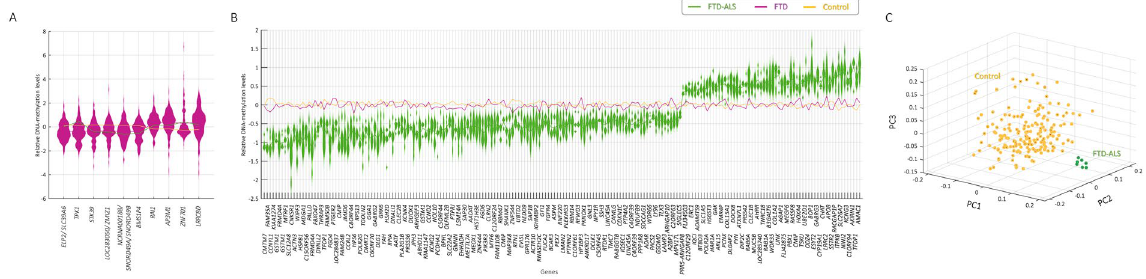
Figure 1. Differential methylated genes for FTD and FTD-ALS. Violin plot depicting the significant differential cytosine DNA-methylated genes are depicted for ( A ) all the 128 FTD cases, and ( B ) the FTD-ALS cases by comparison to control cases. Genes are sorted based on T-statistics. Genes with relative value lower than 0 are DNA hypomethylated and relative value higher than 0 are DNA hypermethylated. The green, purple and yellow lines depict the average value for respectively FTD-ALS, FTD and control cases. ( C ) Principal Component analysis on the differential DNA-methylated probes from